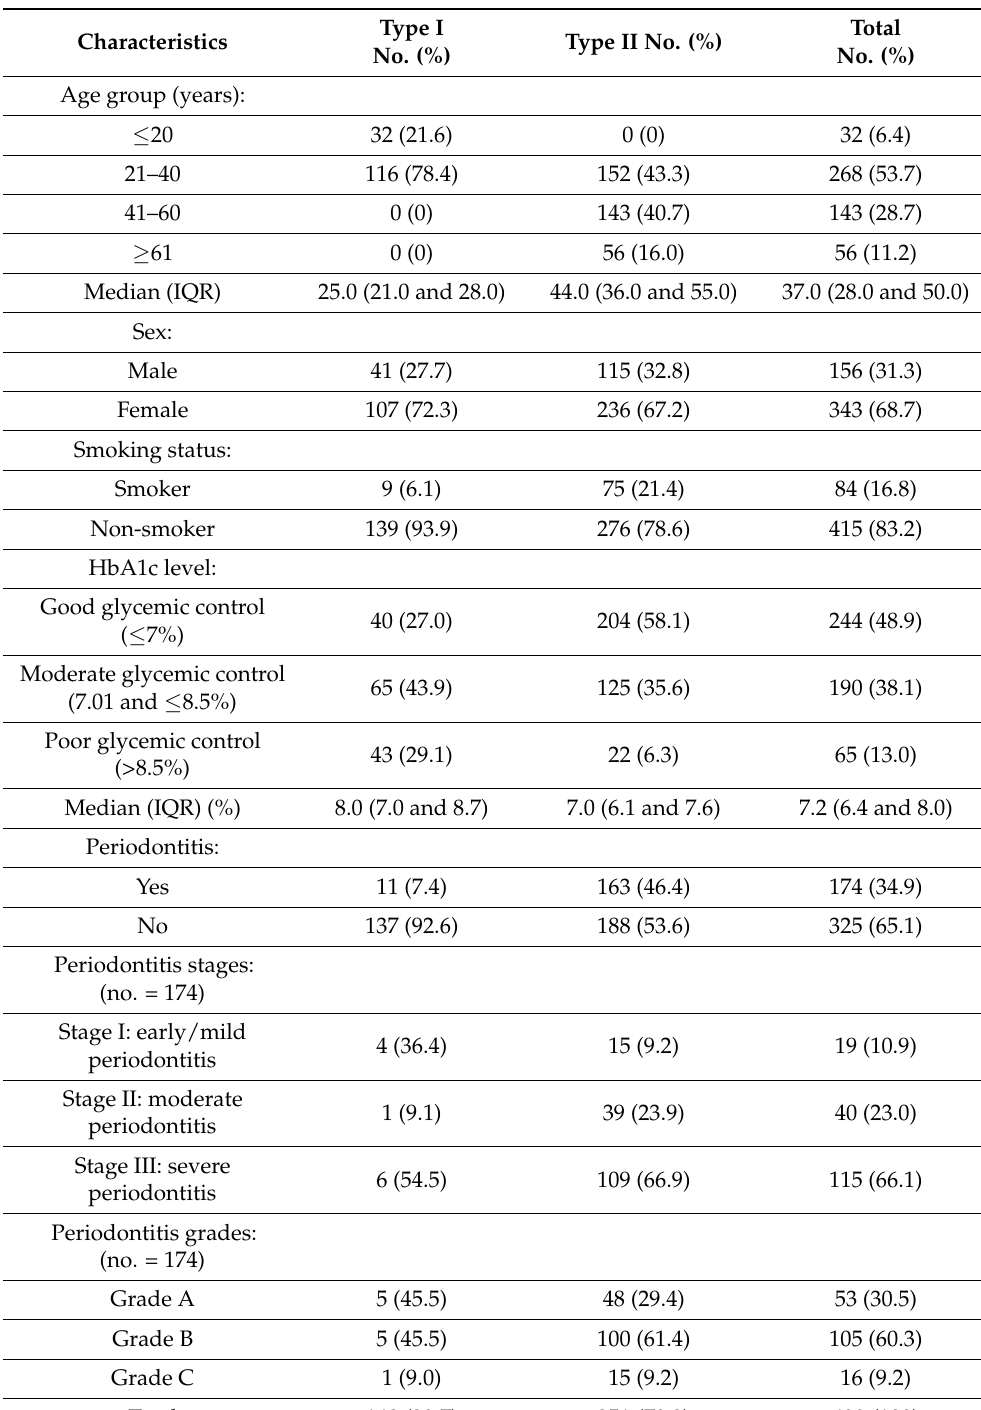
Table 1. Characteristics of type I and II diabetes mellitus